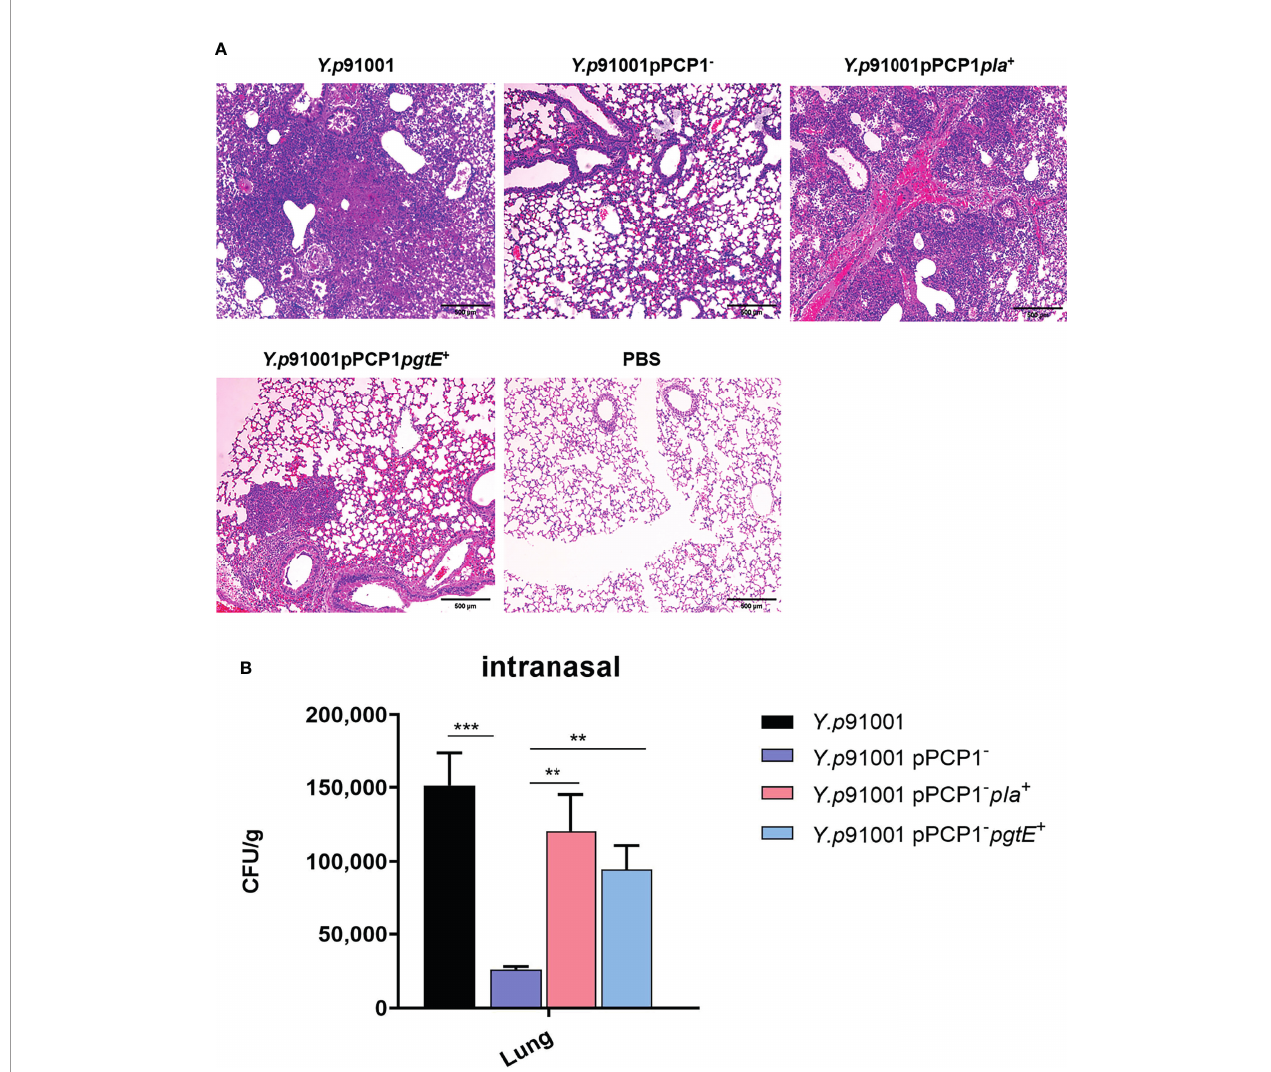
FIGURE 5 | The expression of PgtE in Y. pestis was able to enhance the in fl ammatory lesions in the lungs from C57BL/6 mice. (A) Y.p 91001, Y.p 91001pPCP1 - , Y.p 91001 pPCP1 - pla + and Y.p 91001 pPCP1 - pgtE + were used to challenge mice via the intranasal route. Lung damage was examined by hematoxylin and eosin (H & E) staining of formalin- fi xed sections 48 hours after infection. C57BL/6 mice were inoculated with PBS (mock), Y. pestis Y.p 91001, Y.p 91001pPCP1 - , Y.p 91001 pPCP1 - pla + and Y.p 91001pPCP1 - pgtE + strains Representative images of in fl ammatory lesions are shown. (B) The bacteria amount in the lung tissues of the mice infected by Y.p 91001, Y.p 91001pPCP1-, Y.p 91001 pPCP1-pla + and Y.p 91001 pPCP1-pgtE + were examined 8 hours after infection. **P < 0.01, ***P <